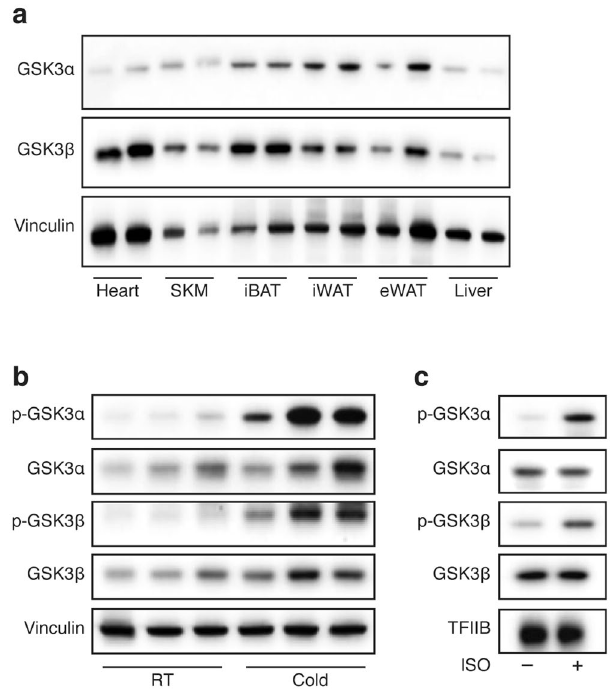
Figure 4. Cold and β -adrenergic signaling cause inhibitory phosphorylation of GSK3 in brown adipocytes. ( a ) Immunoblot analysis of total GSK3 α and GSK3 β in various key metabolic tissues from 10 weeks old male C57BL/6JBomTac mice housed at room temperature; SKM (skeletal muscle). ( b ) Immunoblot analysis of total and phosphorylated GSK3 α and GSK3 β in iBAT from 10 weeks old male C57BL/6JBomTac mice housed at room temperature (RT) or 4 °C (cold) for 24 h. ( c ) Immunoblot analysis of total and phosphorylated GSK3 α and GSK3 β in immortalized brown adipocytes treated with 0.1 μ M ISO for 1 h. Vinculin (tissues) or TFIIB (cells) serves as loading control. Full-length blots/gels are presented in Supplementary Fig.